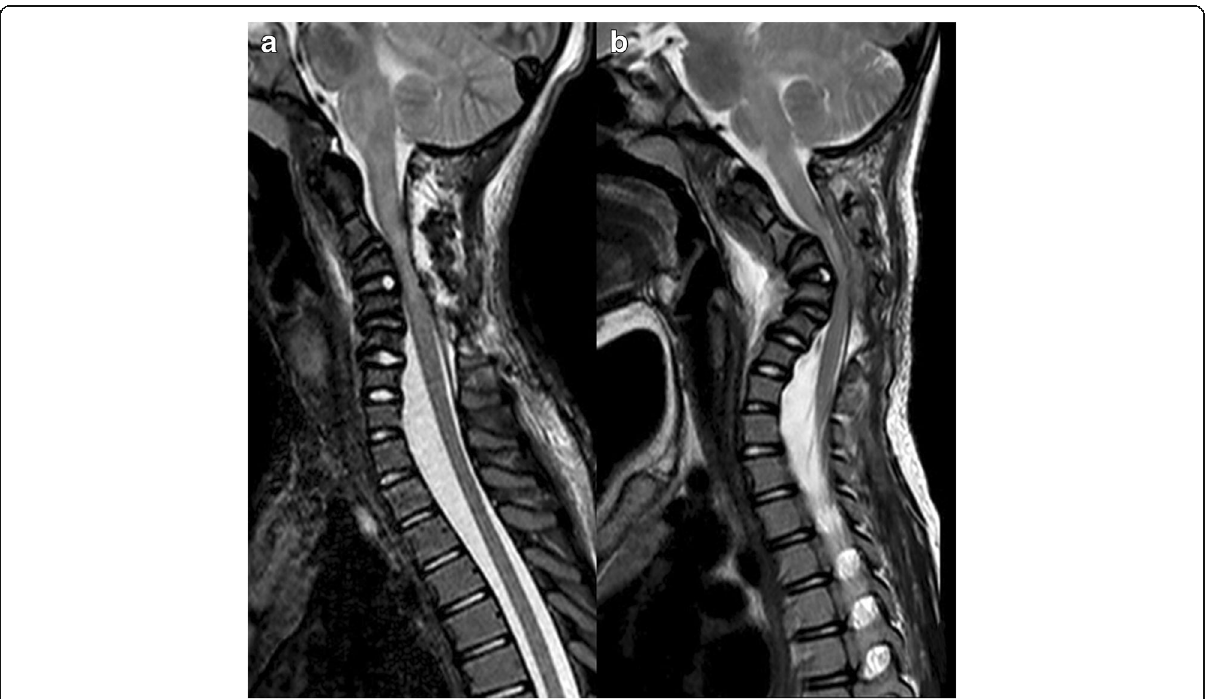
Fig. 2 a Postoperative T2-weighted sagittal MRI showing total resection of the lesions. b T2-weighted sagittal MRI demonstrating progression of kyphotic deformity